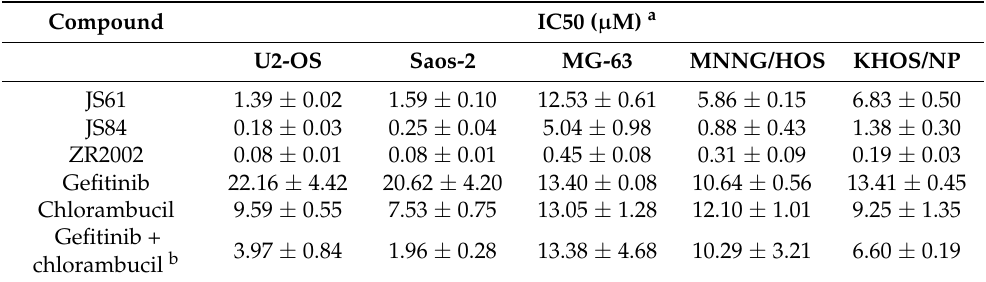
Table 1. Growth inhibition potencies of the various combi-molecules against osteosarcoma cells. Compound IC50 ( µ M) a U2-OS Saos-2 MG-63 MNNG/HOS KHOS/NP